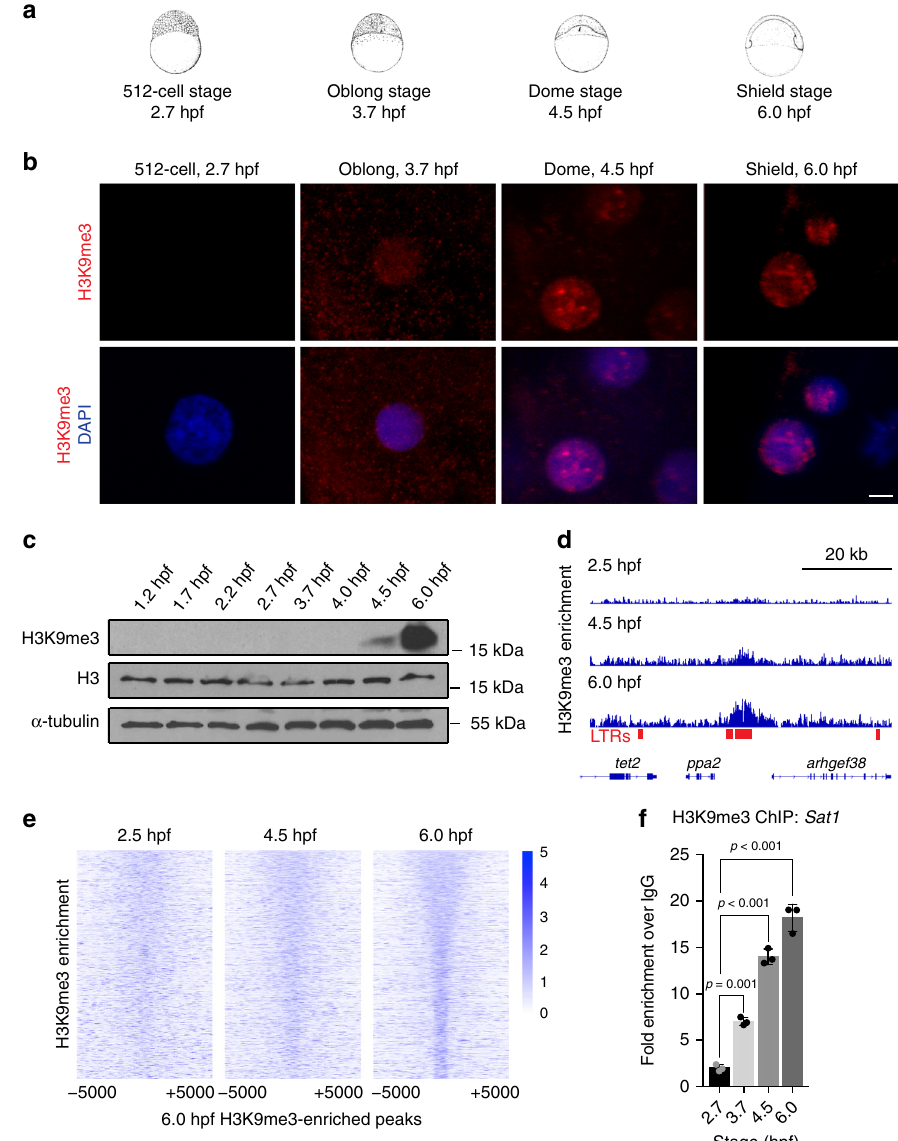
Fig. 1 Chromatin of the early zebra fi sh embryo lacks H3K9me3. a Developmental stages used for heterochromatin analysis. Zebra fi sh embryonic stage schematics are reproduced from Kimmel et al. 22 with permission from John Wiley & Sons Inc. b Representative images showing H3K9me3 immuno fl uorescent antibody labeling of nuclei from fi xed embryos at 2.7, 3.7, 4.5, and 6 h post fertilization (hpf). Images are representative of three independent experiments with at lease 15 embryos observed at each time point in each experiment. Top panels show H3K9me3 labeling (red). Bottom panels show H3K9me3 (red) overlaid with 4 ′ ,6-diamidino-2-phenylindole (DAPI) (blue). All images were taken under identical conditions, the scale bar represents 1 μ m. c Western blots for H3K9me3, histone H3, and α -tubulin. For each time point, total protein extracts were isolated from 20 embryos, and one-third of the protein extract for each sample was loaded for western blot. d , e H3K9me3 enrichment measured by chromatin immunoprecipitation with sequencing (ChIP-seq) at 2.5, 4.5, and 6 hpf. d Screen shot of H3K9me3 enrichment at an LTR transposon in a representative genomic region. e